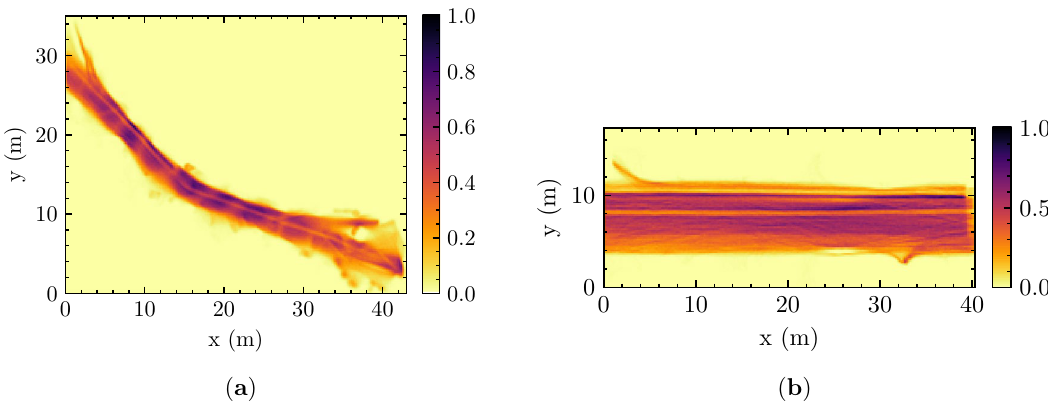
Figure 1. The normalized cumulative density maps for ( a ) the ATC data set and ( b ) DIAMOR data set. The environment is discretized as a 2D mesh with a grid cell size of 10 cm by 10 cm, and the number of observations is counted in each grid cell. Normalization refers to the scaling of this histogram with its maximum